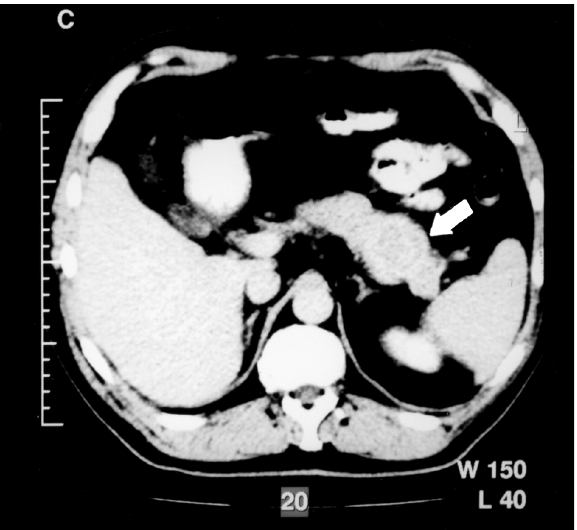
Figure 2 - Pancreatic metastasis of renal clear cell carcinoma. Note the pancreatic nodule between body and tail of pancreas